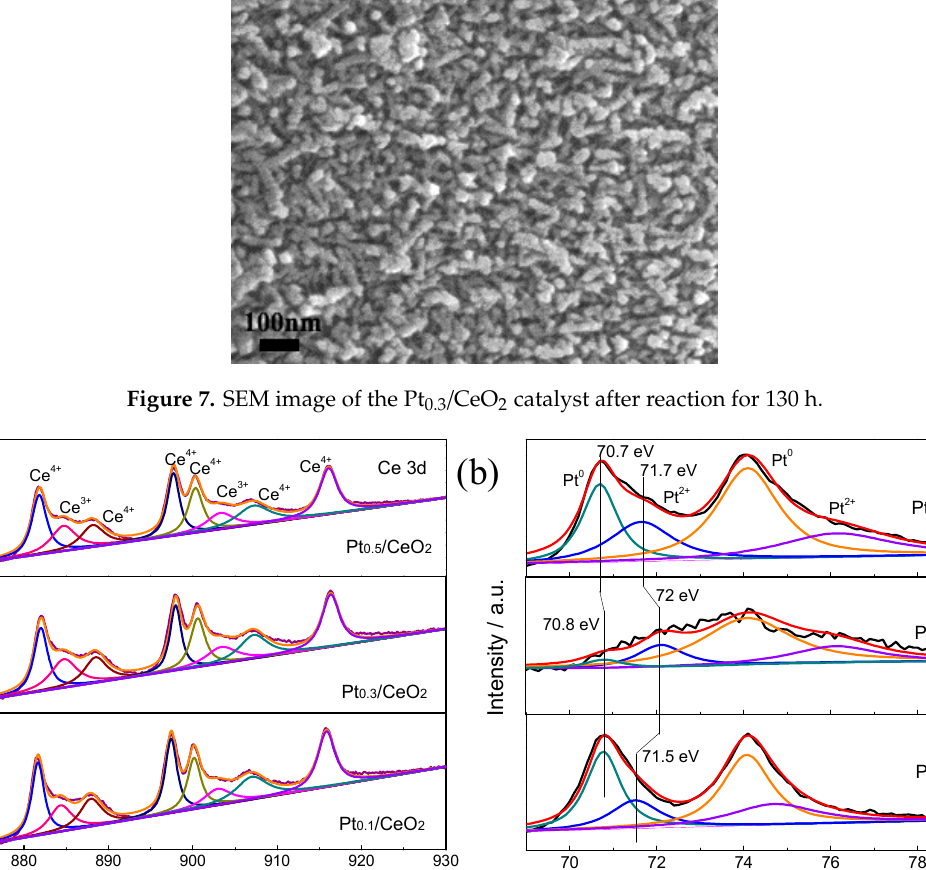
Figure 8. X-ray photoelectron spectroscopy (XPS) spectra of ( a ) the Ce 3d and ( b ) the Pt 4f peaks for the Pt 0.1 /CeO 2 , Pt 0.3 /CeO 2 and Pt 0.5 /CeO 2 catalysts.